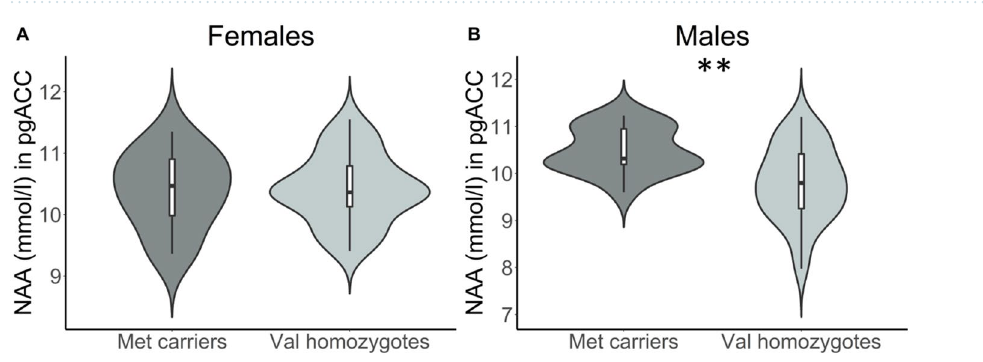
Figure 2. Absolute quantification. Results of follow-up linear regression models for ( a ) Glutamate, ( b ) Glutamine, and ( c ) NAA, with BDNF Val66Met genotype (Met homozygote or Val carrier) as predictor, controlling for age and gender. Violin plots show the distribution of metabolite values, uncorrected for covariates. * P < .05 after Bonferroni correction for multiple comparisons. Mmol/l millimolar; Glu glutamate; Gln glutamine; NAA N-acetylaspartate.